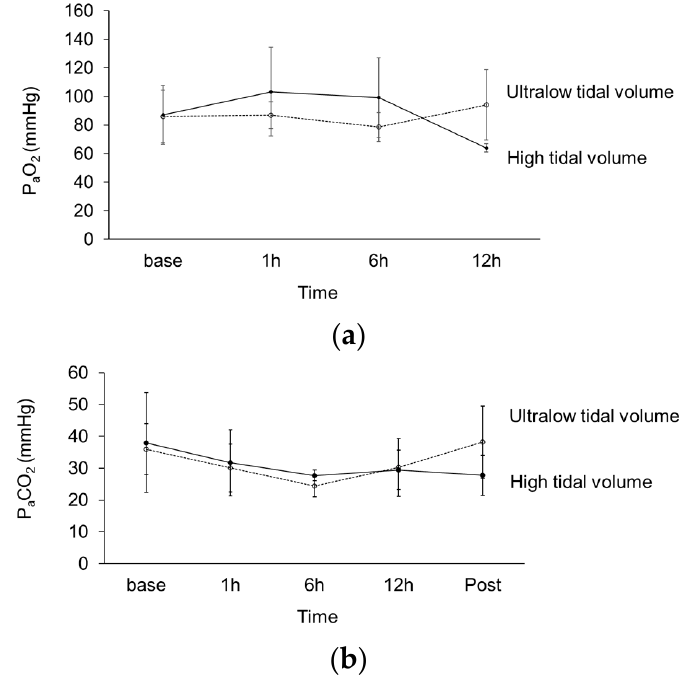
Figure 2. Change in the arterial partial pressure of ( a ) oxygen (PaO 2 ) and ( b ) carbon dioxide (PaCO 2 ), with the straight line depicting the high-tidal-volume ventilation group and the dotted line depicting the ultralow tidal ventilation group under ECMO support; h: Hour.